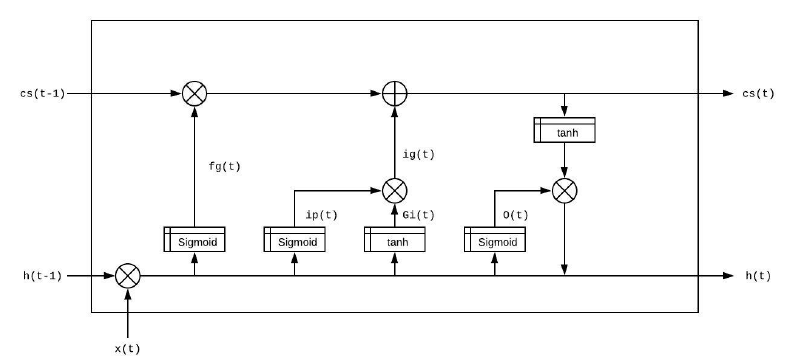
Figure 1. Structure of long short-term memory (LSTM) model: the repeating module has three different types of gates, namely, the forget gate, fg(t); the input gate, ig(t) (=ip(t) × Gi(t)); the output gate, O(t).